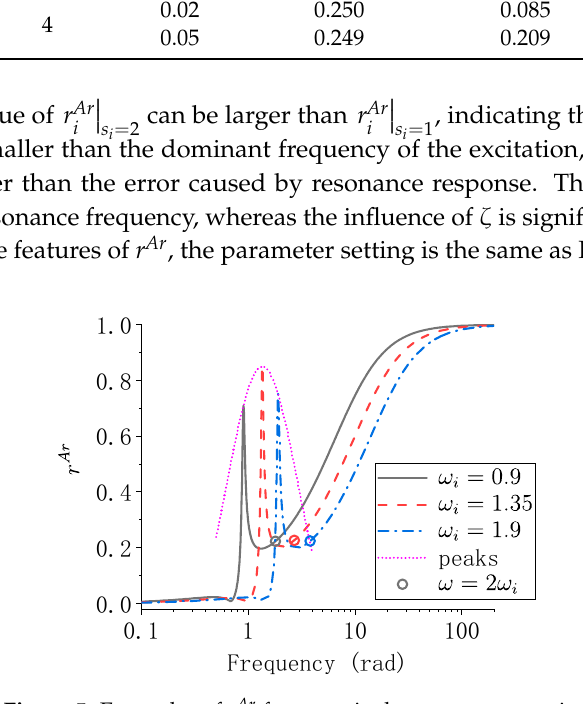
Figure 5. Examples of Ar r for a particular parameter setting.